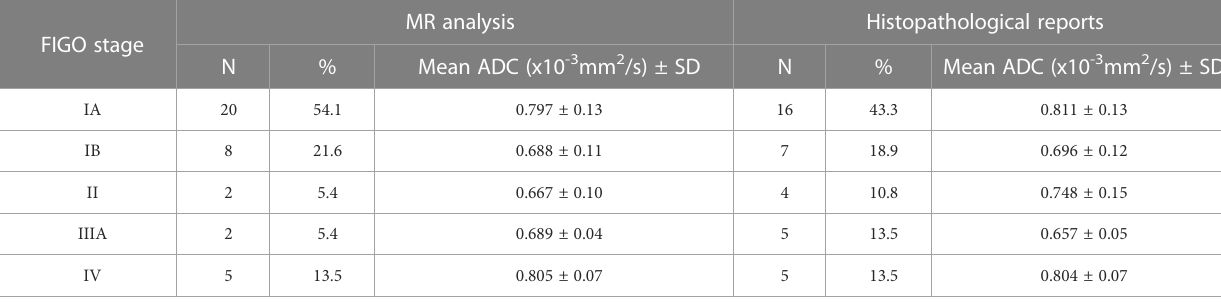
TABLE 3 FIGO stages of EC based on MRI analysis and histopathological reports.